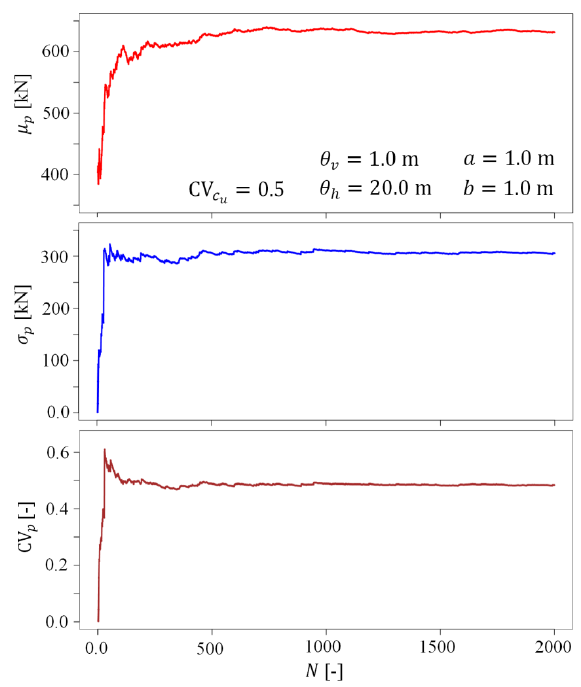
Figure 5: Mean value, standard deviation and variation coefficient of bearing capacity as a function of simulation number N . The square foundation is assumed with geometry parameters and fluctuation scales detailed in the